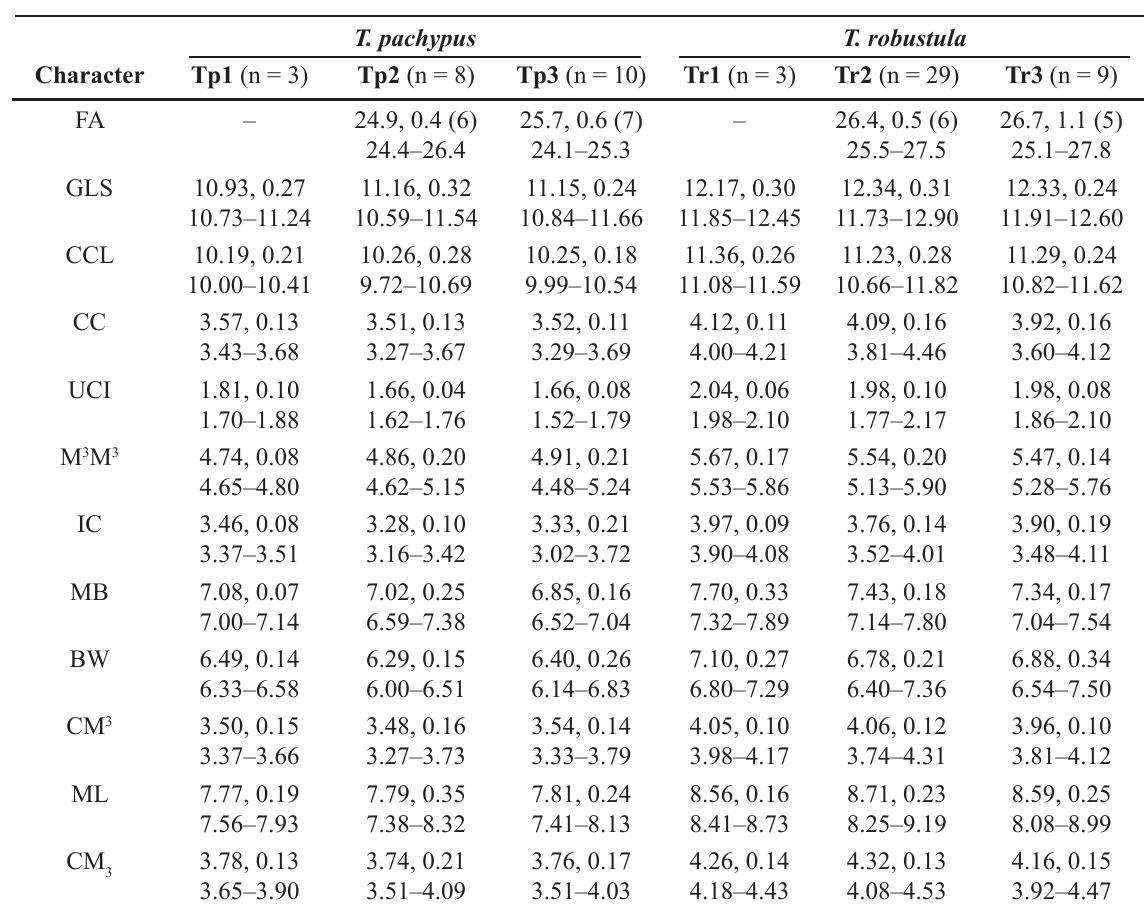
Table 2. Selected external and craniodental measurements (in mm) of Tylonycteris spp. Values are given as mean, standard deviation (SD), (n) and min–max. Acronyms and definitions for measurements are given in Material and